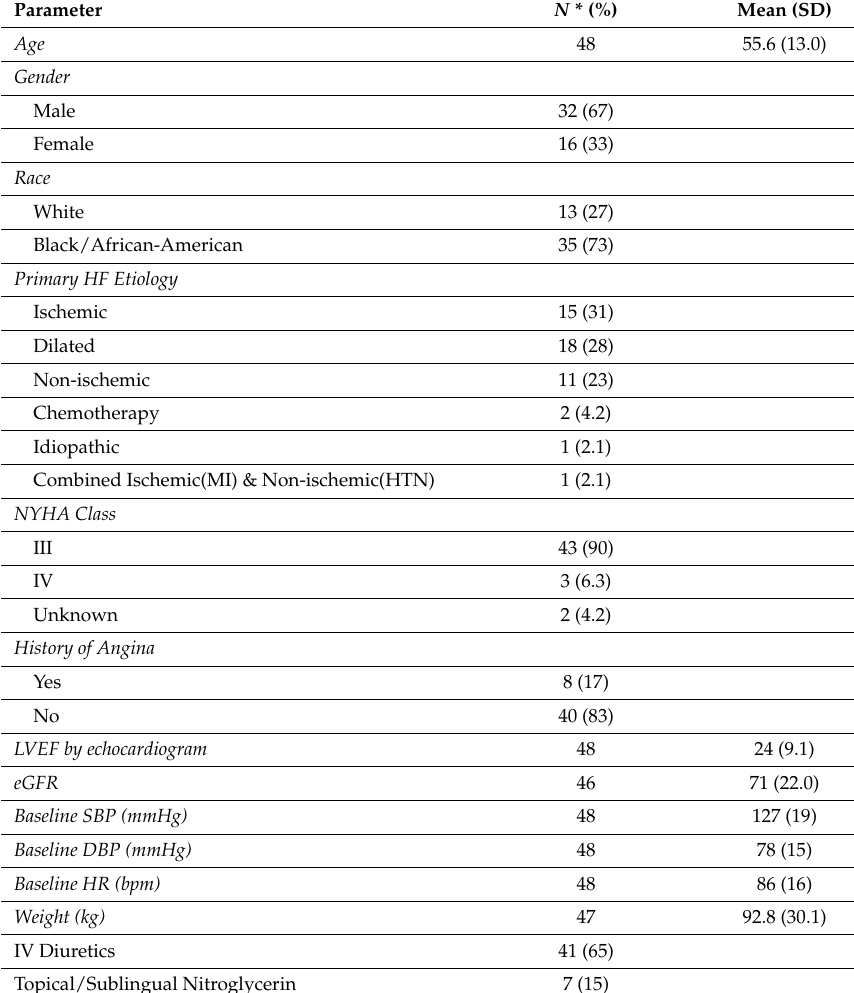
Table 1. Demographics and baseline characteristics of the study